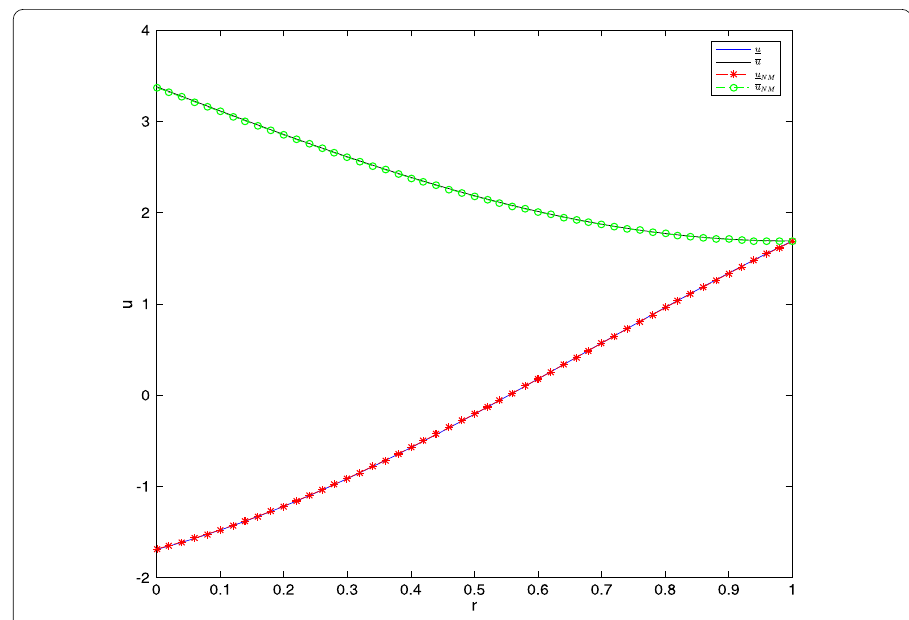
Figure 9 Exact solution and approximate solution with N = 2 of Example 5.3